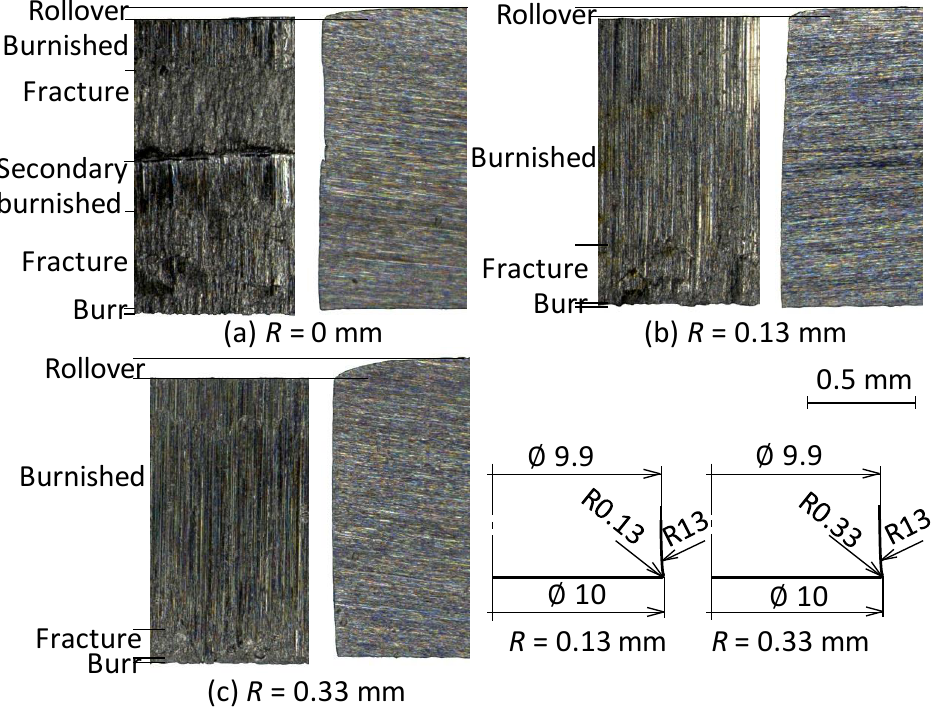
Figure 9. Surfaces and cross-sections of punched edges of 980 MPa sheets with punch having small round corner for clearance ratio of 0.8% of ( a ) R = 0 mm, ( b ) R = 0.13 mm and ( c ) R = 0.33 mm [55]. Since the setting of the slight clearance punching process with the punch having a small round corner is not easy, a punching process using automatic centring with a moving die was proposed (see Figure 10) [56]. The punch and moving die are initially eccentric, i.e., the left and right clearances between the punch and die are not the same. In this process, the slight gap is located between the moving die and die holder, and the die is moved by the action of force. When the left and right clearance are different, an imbalanced force acts to the moving die, and then the moving die shifts in order to decrease the imbalanced force. After some shots, the punch and die become concentric.